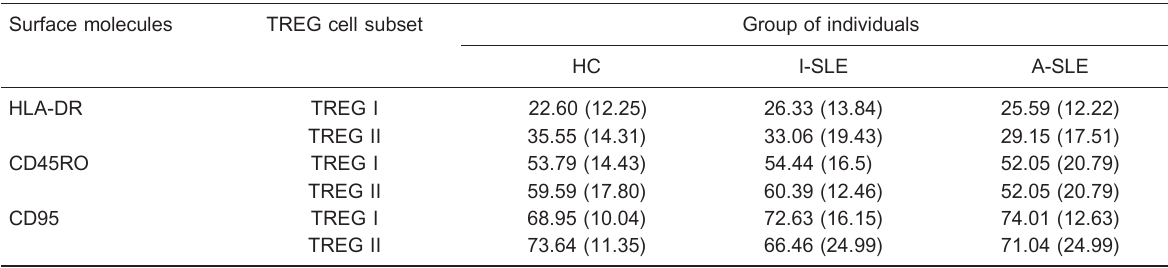
Table 1. Relative frequency of TREG cells expressing HLA-DR, CD45RO, and CD95 in patients with SLE and HC. Surface molecules